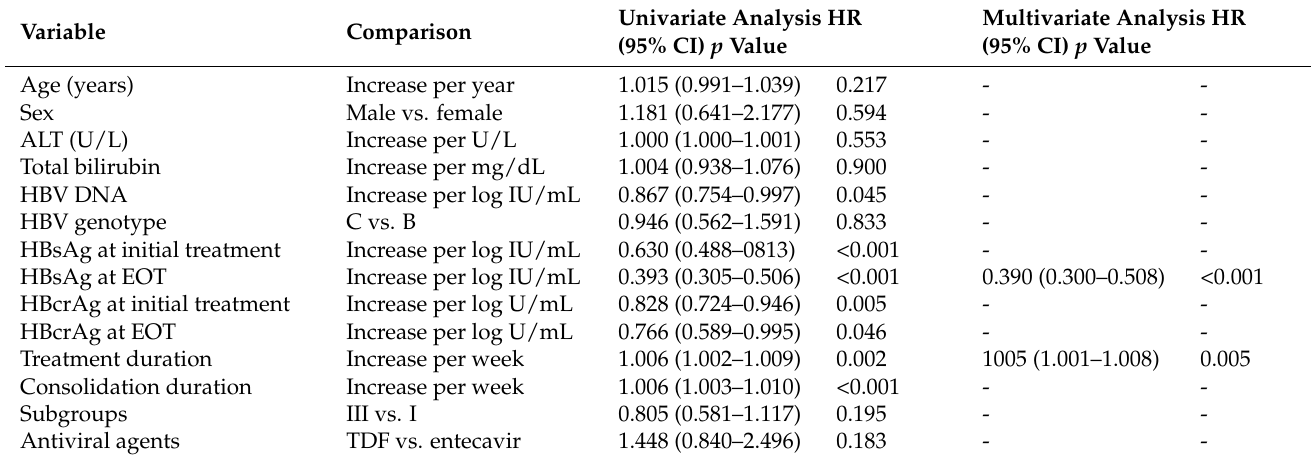
Table 5. Factors associated with HBsAg loss in the patients of Groups I and III.